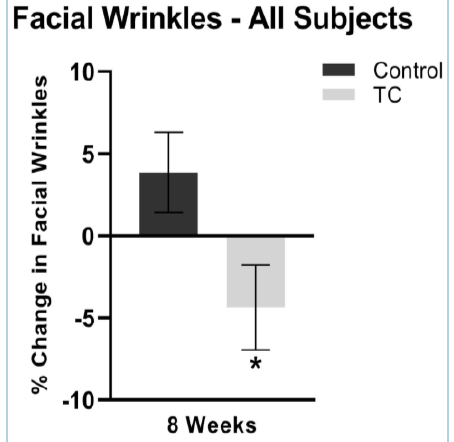
Figure 5. Facial wrinkles after 8 weeks, compared to pretreatment baseline (all subjects). N = 38, * p < 0.05. There were no side effects noted.